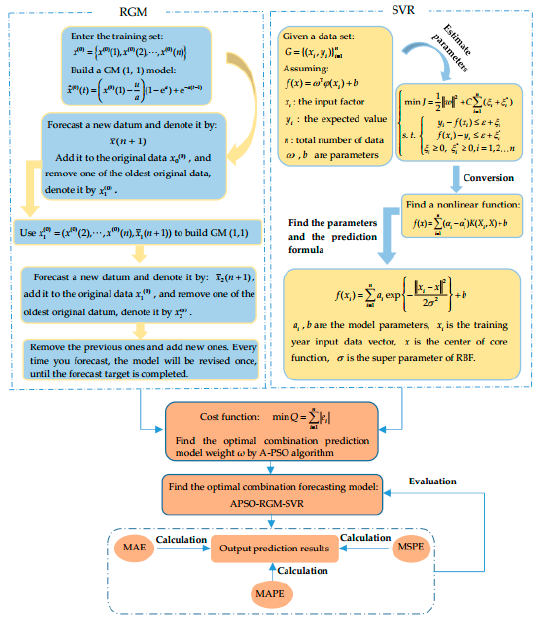
Figure 5. The procedure of APSO-RGM–SVR model.